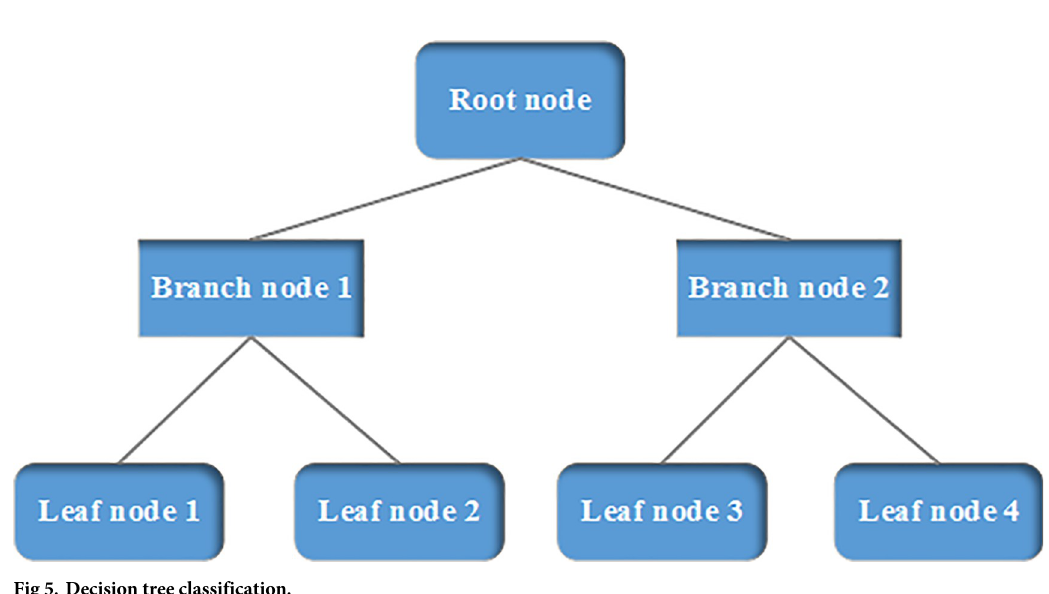
Fig 5. Decision tree